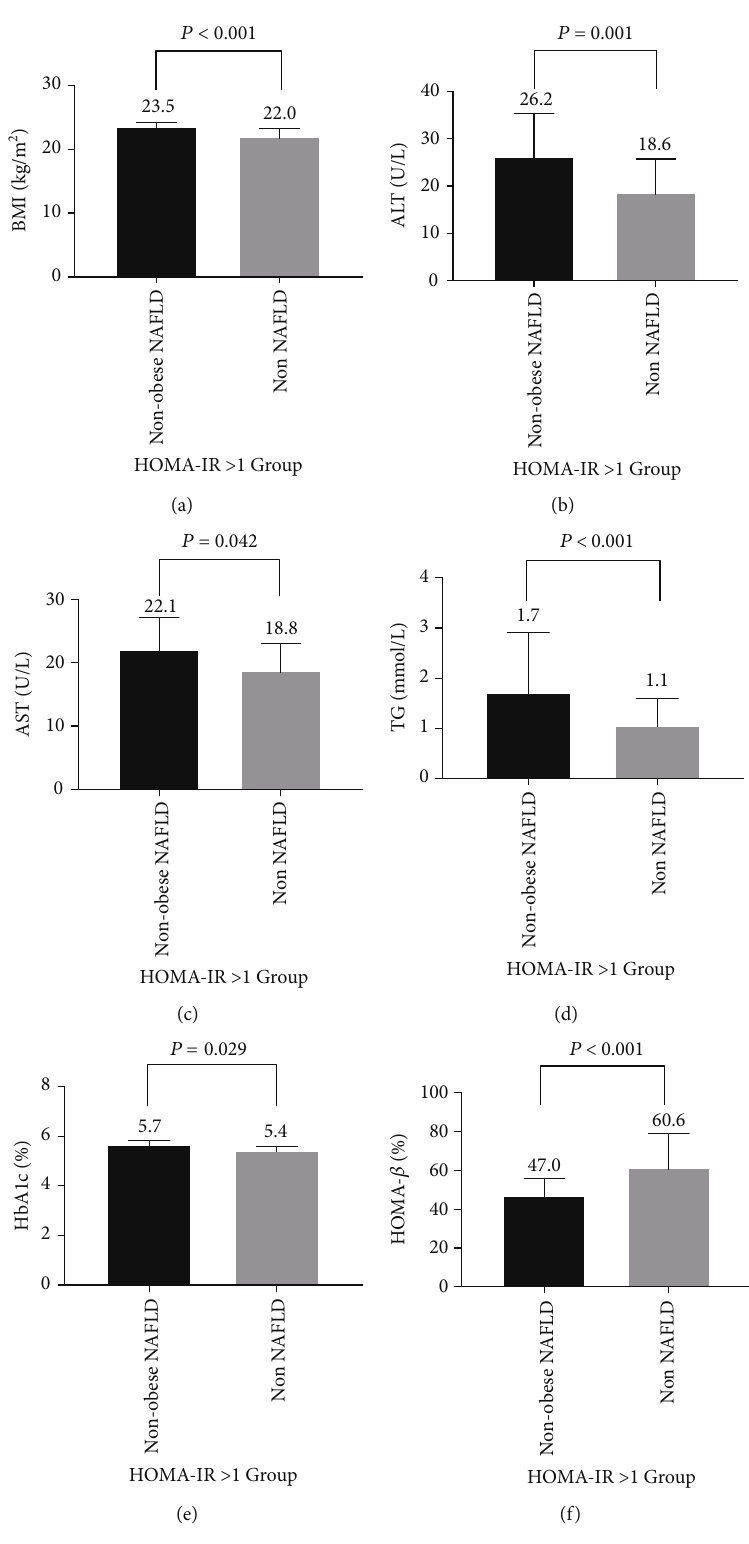
Figure 1: HOMA − IR > 1 group. The characteristics of the participants of nonobese NAFLD and non-NAFLD. (a) BMI; (b) ALT; (c) AST; (d) TG; (e) HbA1c; (f) HOMA- β